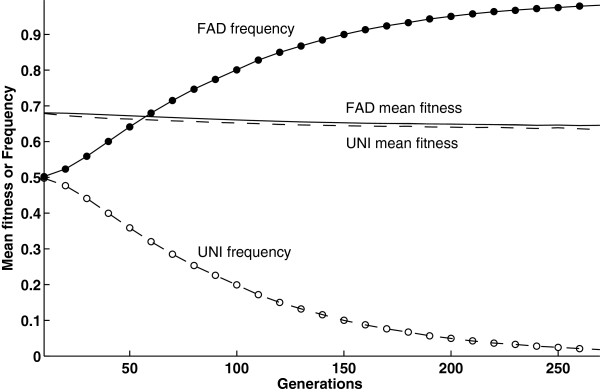
FAD can invade despite a long-term disadvantage. The figure shows the frequency and mean fitness of FAD (filled markers solid line and solid line, respectively) and UNI (open markers dashed line and dashed line, respectively) modifier alleles in an average of 100 runs as a function of time. For this parameter set, FAD succeeds in invading a population with a uniform dispersal rate (with equal average dispersal rates, αF = αU), but the invasion is accompanied by a substantial decrease in mean fitness for both the FAD and the UNI sub-populations. FAD invasion successfully invades because of the abandon-ship advantage: FAD modifier alleles tend to break away more effectively from deleterious genetic backgrounds through dispersal and outcrossing. They become associated with relatively good genetic backgrounds, consistently leading to higher mean fitness than UNI throughout the period of invasion. Parameters: cost of dispersal c = 0, dominance coefficient h = 0.2, average dispersal rate αF = αU =0.1. Qualitatively similar results were obtained for the introduction of FAD modifier alleles at a frequency of 0.01.